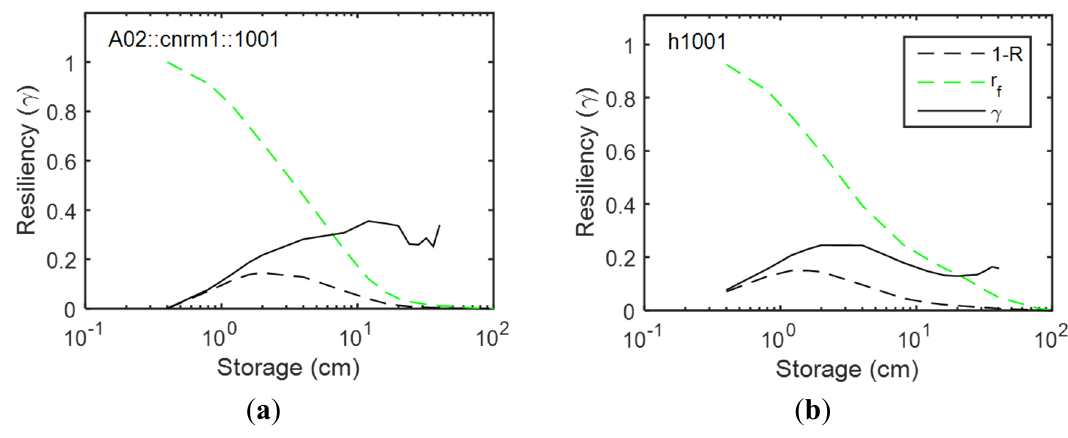
Figure 9. Behavior of the resiliency for ( a ) historical and ( b ) climate change scenarios (A2, CNRM1) for a test catchment, 1001 with N c